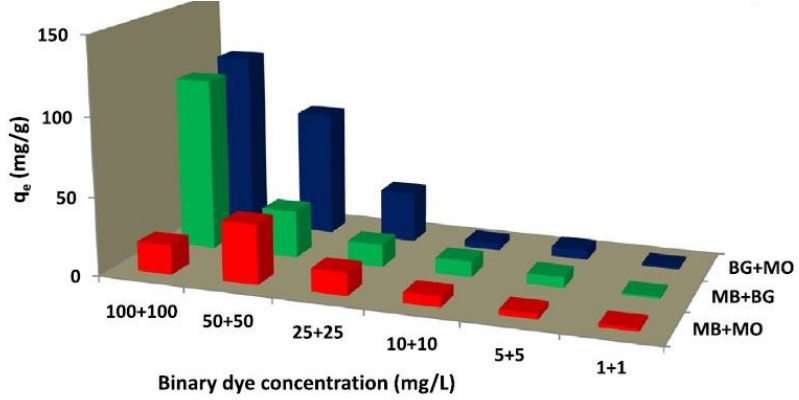
Figure 9. Removal in binary dye adsorption system using CCC (ref. [78]).